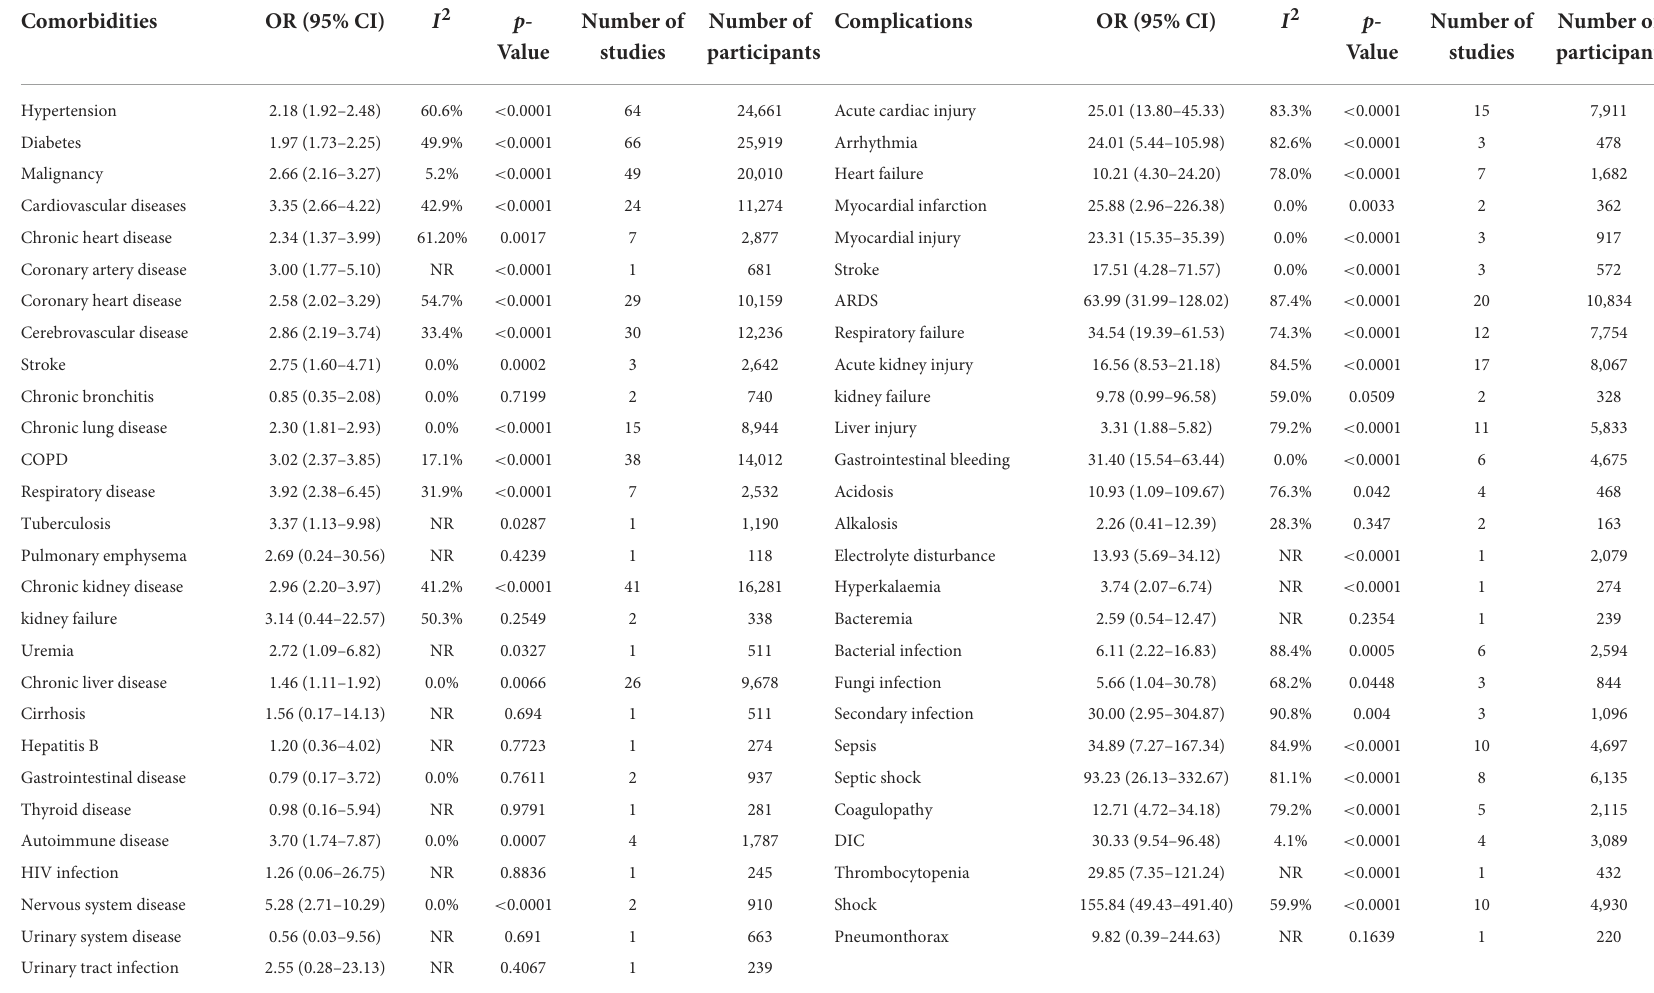
TABLE 4 Meta-analysis summary of mortality for COVID-19 with comorbidities and complications vs. without comorbidities and complications.